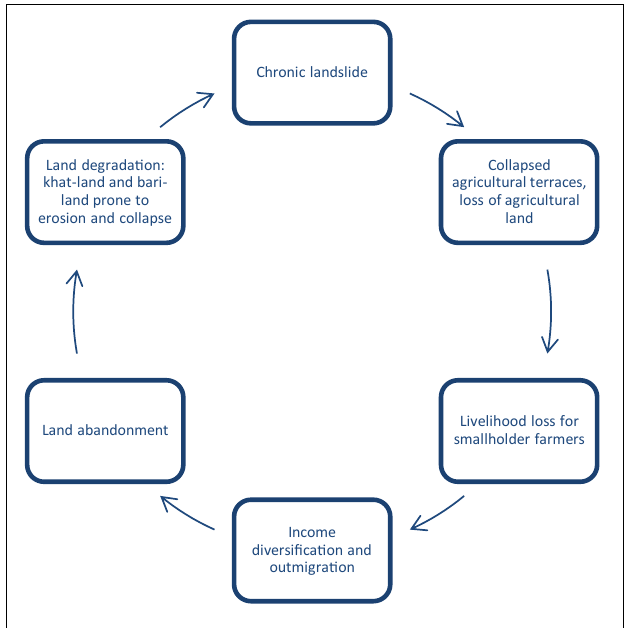
FIGURE 6 | Landslide and livelihoods